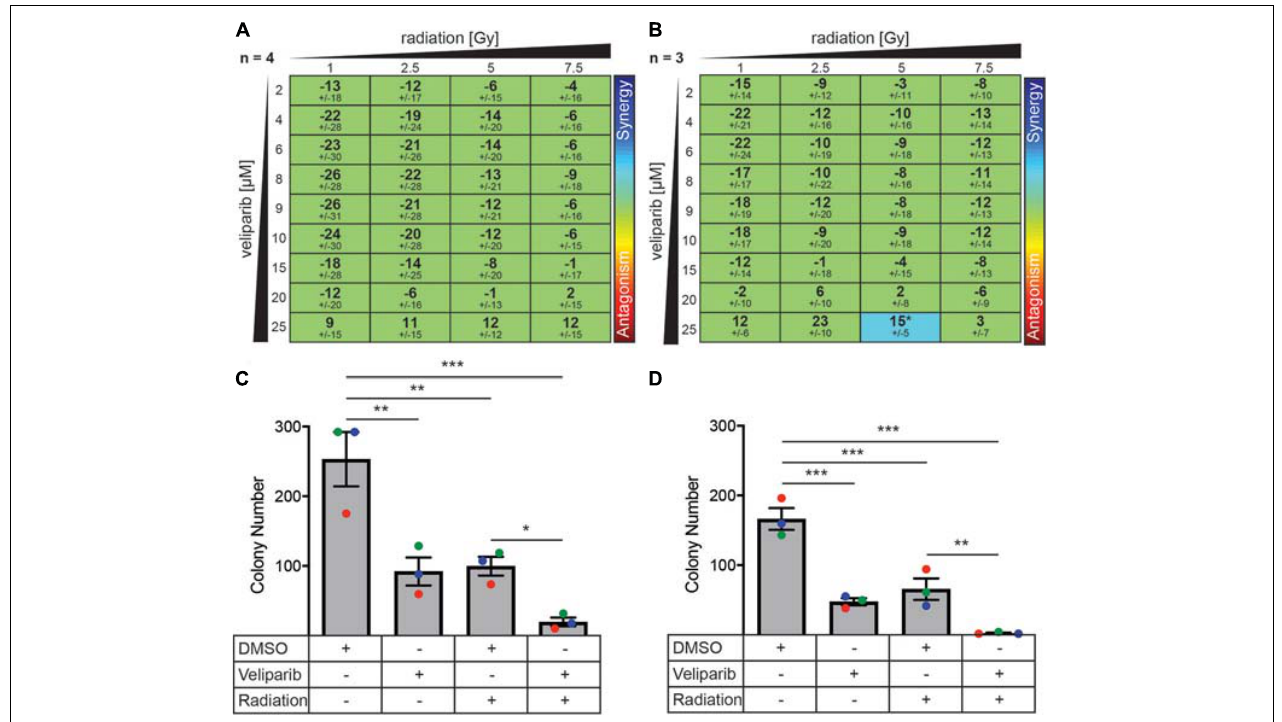
FIGURE 2 | PARP inhibitors enhance radiation-induced cytotoxicity and decrease colony forming ability in medulloblastoma cells. (A) D425GiL and (B) D283Luc2 cells were treated with increasing doses of radiation combined with veliparib and the mean ± SD synergy score for each combination was calculated using the Loewe Additivity model. Values greater than or less than zero indicate synergy or antagonism, respectively (indicated by the rainbow heat map). The number ( n ) of independent experiments used in the analysis is shown, and statistical comparisons were performed as described by Di Veroli et al., 2016. * p < 0 . 05. (C) D425Gil and (D) D283Luc2 cells were treated with DMSO, veliparib, 2 Gy irradiation or a combination of veliparib and irradiation as indicated and plated in methylcellulose. The mean number of colonies formed ± SEM is shown from three independent experiments (indicated in different colors). Groups were compared using one-way ANOVA with Holm–Sidak multiple testing correction. * p < 0.05, ** p < 0.01, *** p <